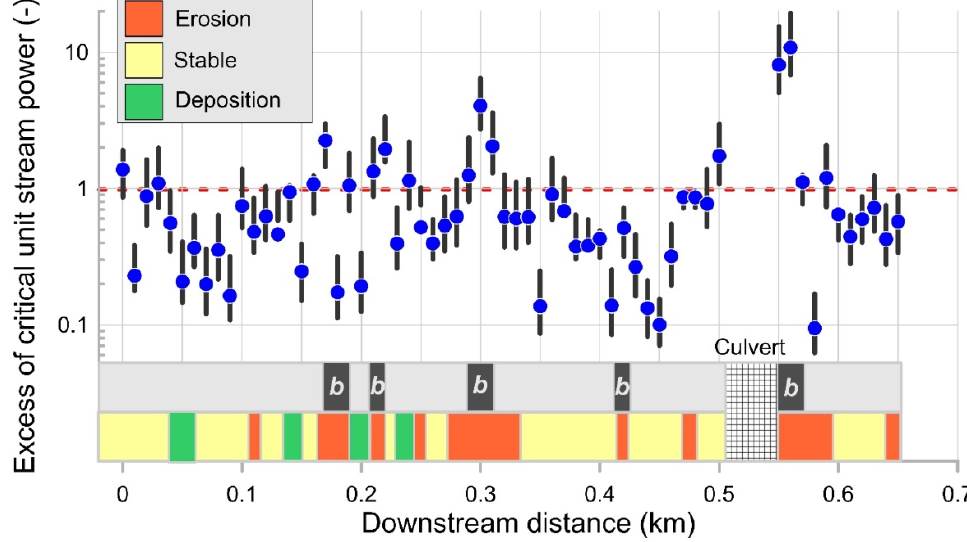
Figure 11. Downstream variations in the excess of critical unit stream power for the 2014 event (critical threshold 1 is indicated by the red dashed line) and dominant fluvial processes. The individual blue points represent values calculated for the Q optimum scenario for individual cross sections; the scatter lines around these points indicate the values of the Q min and Q max scenarios. The occurrence of bedrock reaches is indicated by black rectangles marked by ‘b’ letters.